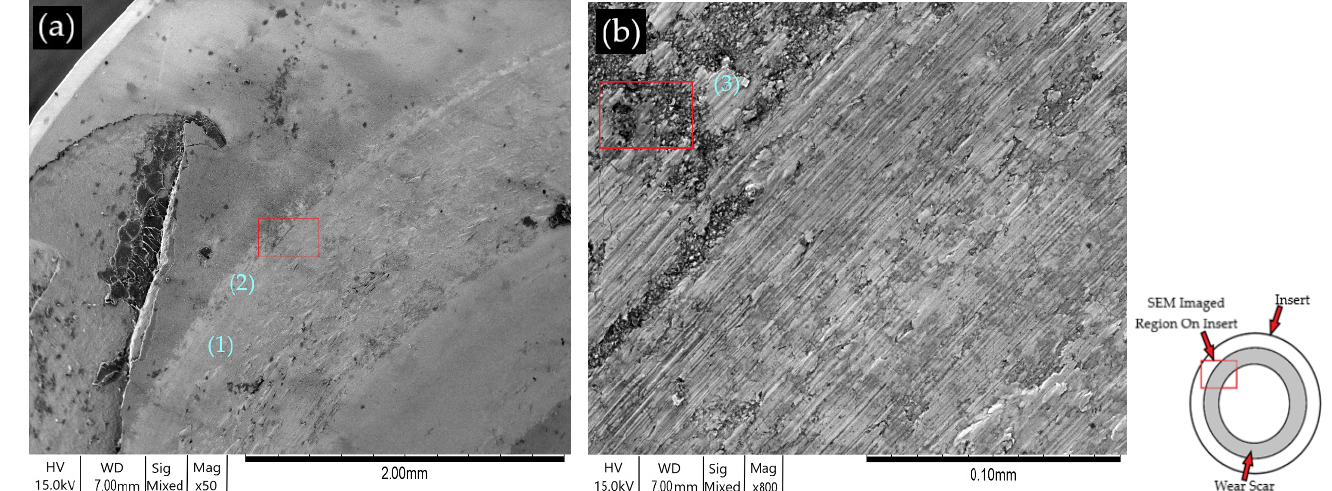
Figure 12. SEM images of Coating B after pin-on-disc Test 2b: ( a ) ×50 magnification, ( b ) ×800 mag- nification.